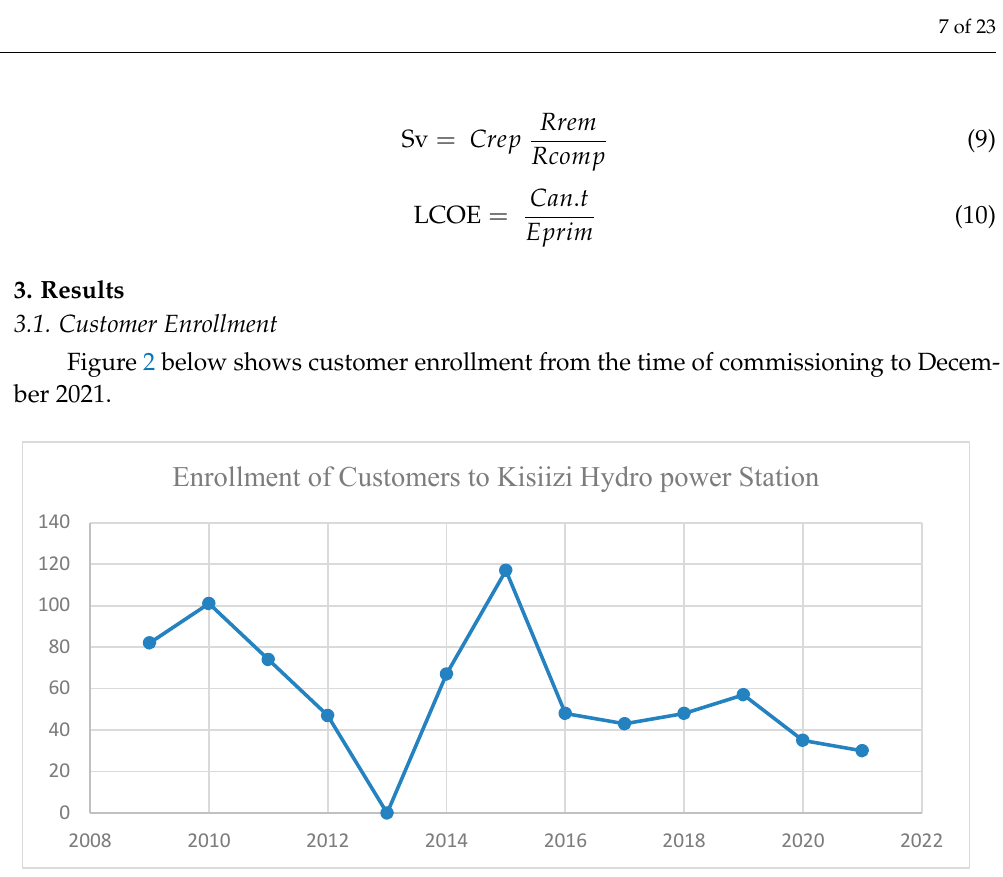
Figure 2. Enrollment of outside customers to KHMG. In 2009, 82 customers were enrolled; in 2010, people were excited, and 101 customers were recruited. In 2011, enrollment declined to 74 and to 47 customers due to system fail- ures. In 2013, the plant was out of function for a whole year due to a complex technical